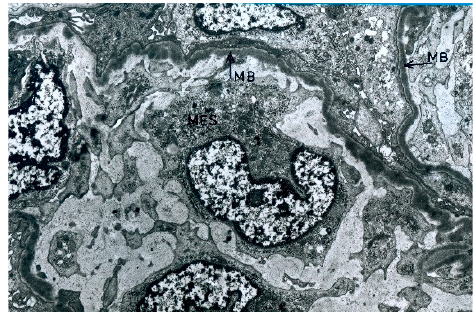
Figure 8. A case of DDD. Electron microscopic image of a glomerulus with a markedly thickened basement membrane structure, as well as a transposition of mesangial cell protrusions. Electron microscopy, 7500× magni fi cation. MB, basement membrane; Mes, mesangium.